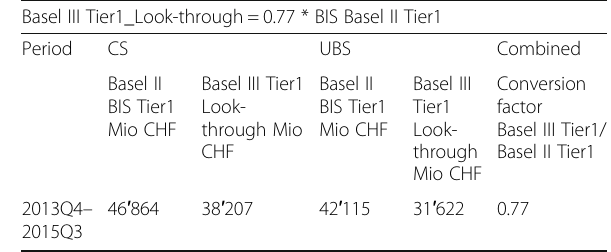
Table 8 Conversion factor: Basel III CET1 Look-through to BIS